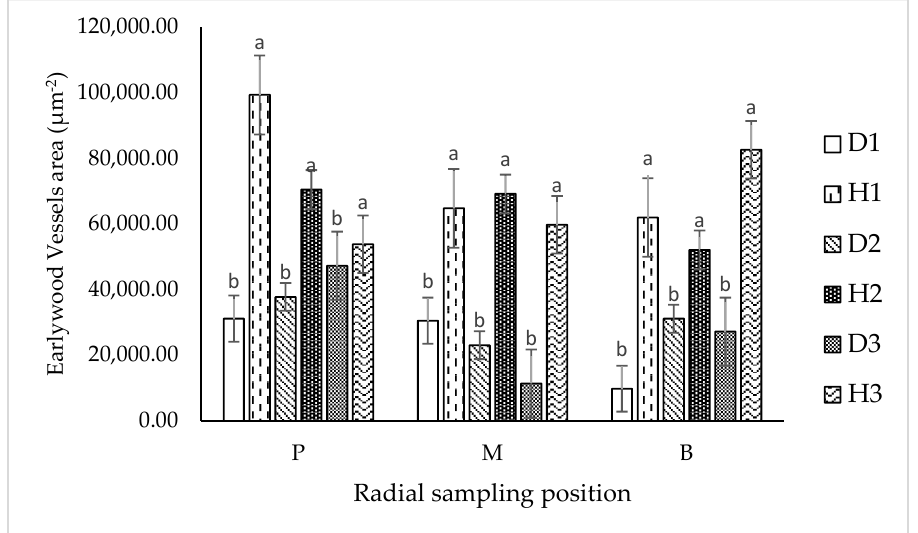
Figure 5. Comparisons of mean area of earlywood vessels in declined and healthy trees of Quercus brantii. H: Healthy trees; D: Declined trees; 1: Area A; 2: Area B; 3: Area C; P: Near-pith; M: Middle; B: Near-bark. The bar on each column represents the SE (standard error).